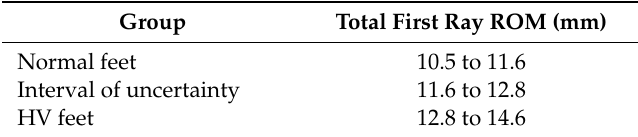
Table 5. Values of the total ROM of the first ray used in assembling the conglomerates for predicting normal or HV